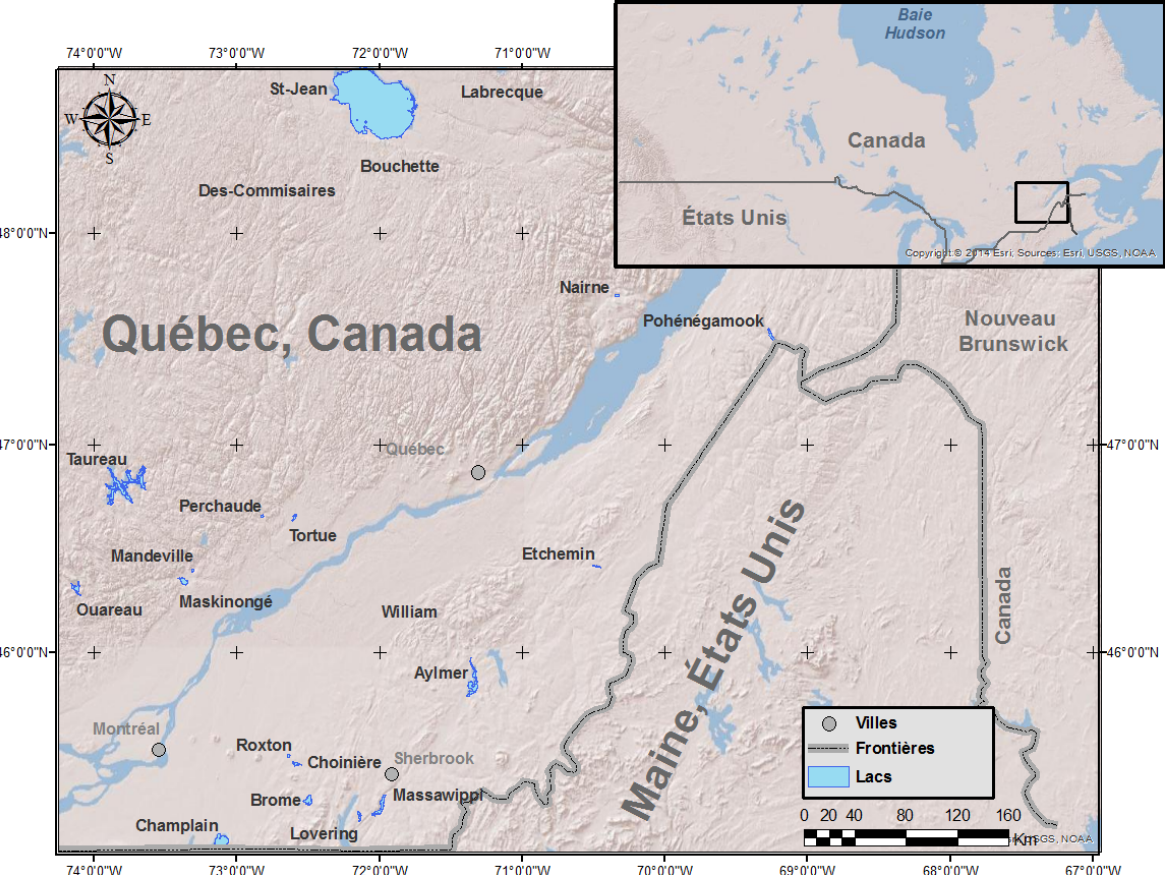
Figure 1. Geographic location of the water bodies used for model calibration and validation.